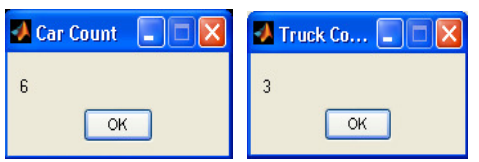
Figure 20: Car & Truck Counts of the ROI in the Reference Image